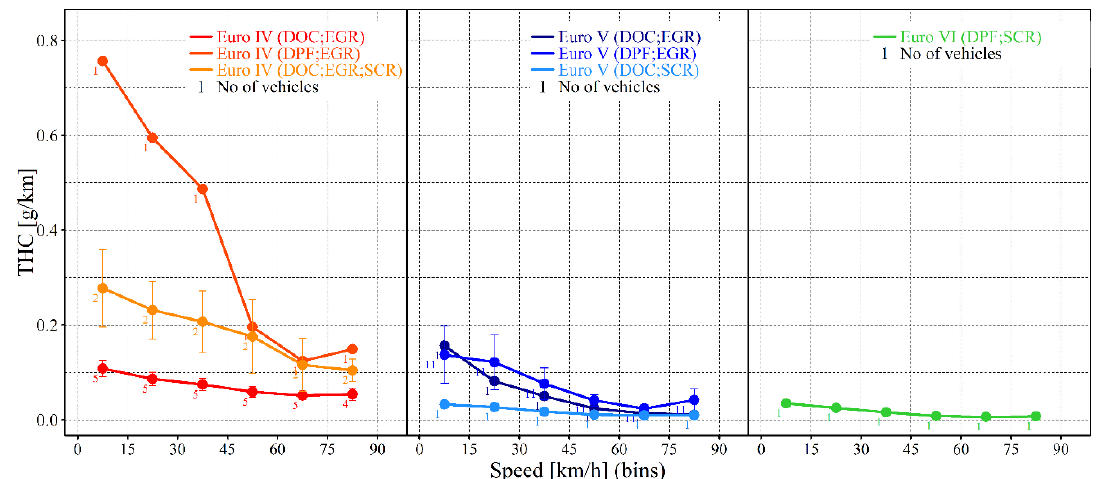
Figure A2. Sample mean and ± one standard error limits of the distance-based THC emission levels over speed (500 m driving sequences).